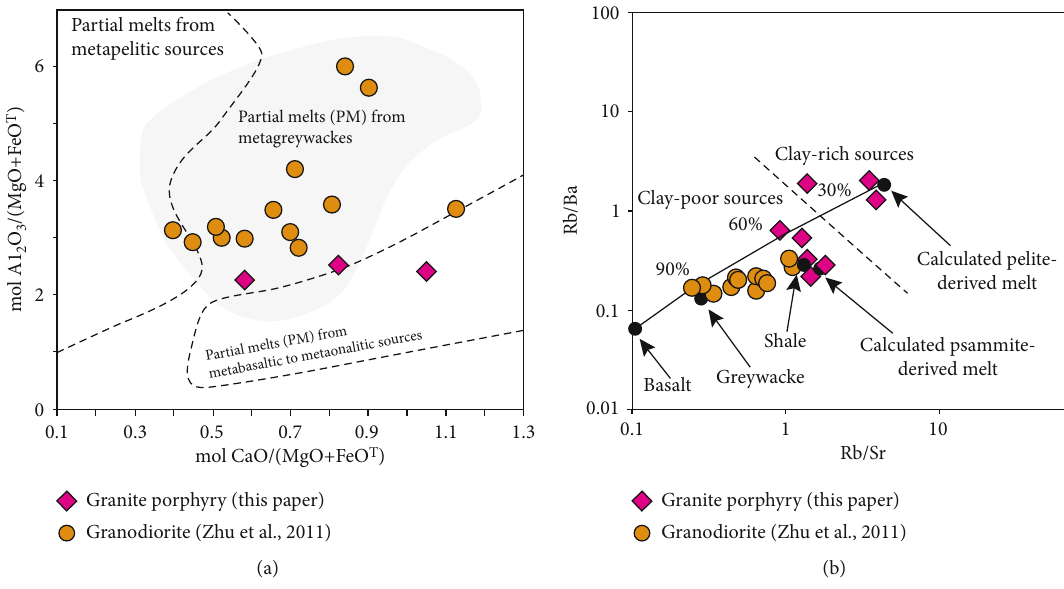
Figure 20: Selected discrimination diagrams for the granite porphyries and granodiorite of the Yangla copper deposit, Yunnan, China ((a)